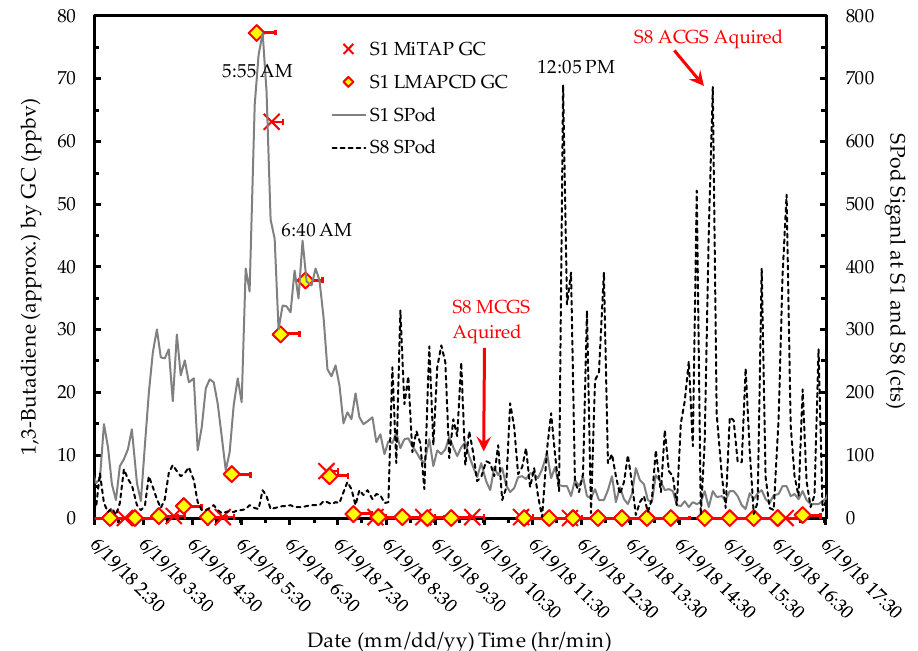
Figure 6. Time-resolved observations of SIS2 with SPod readings (five-minute average) plotted on the secondary ordinate axis. Single side horizontal error bars in GC data indicate the temporal extent of air sampling. The SPod data are non-speciated, and do not directly correspond to 1,3-butadiene. The SIS2 event illustrates the importance of speciated NGEM data acquired at both S1 and S8.